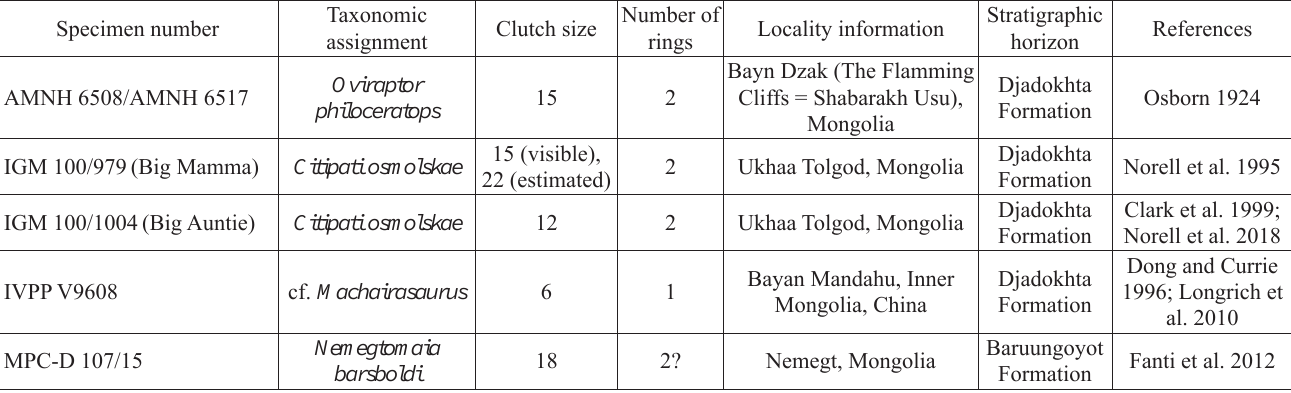
Table 1. Characteristics of previously reported oviraptorid adult-associated clutches. The question mark means number of rings is still uncertain. Specimen